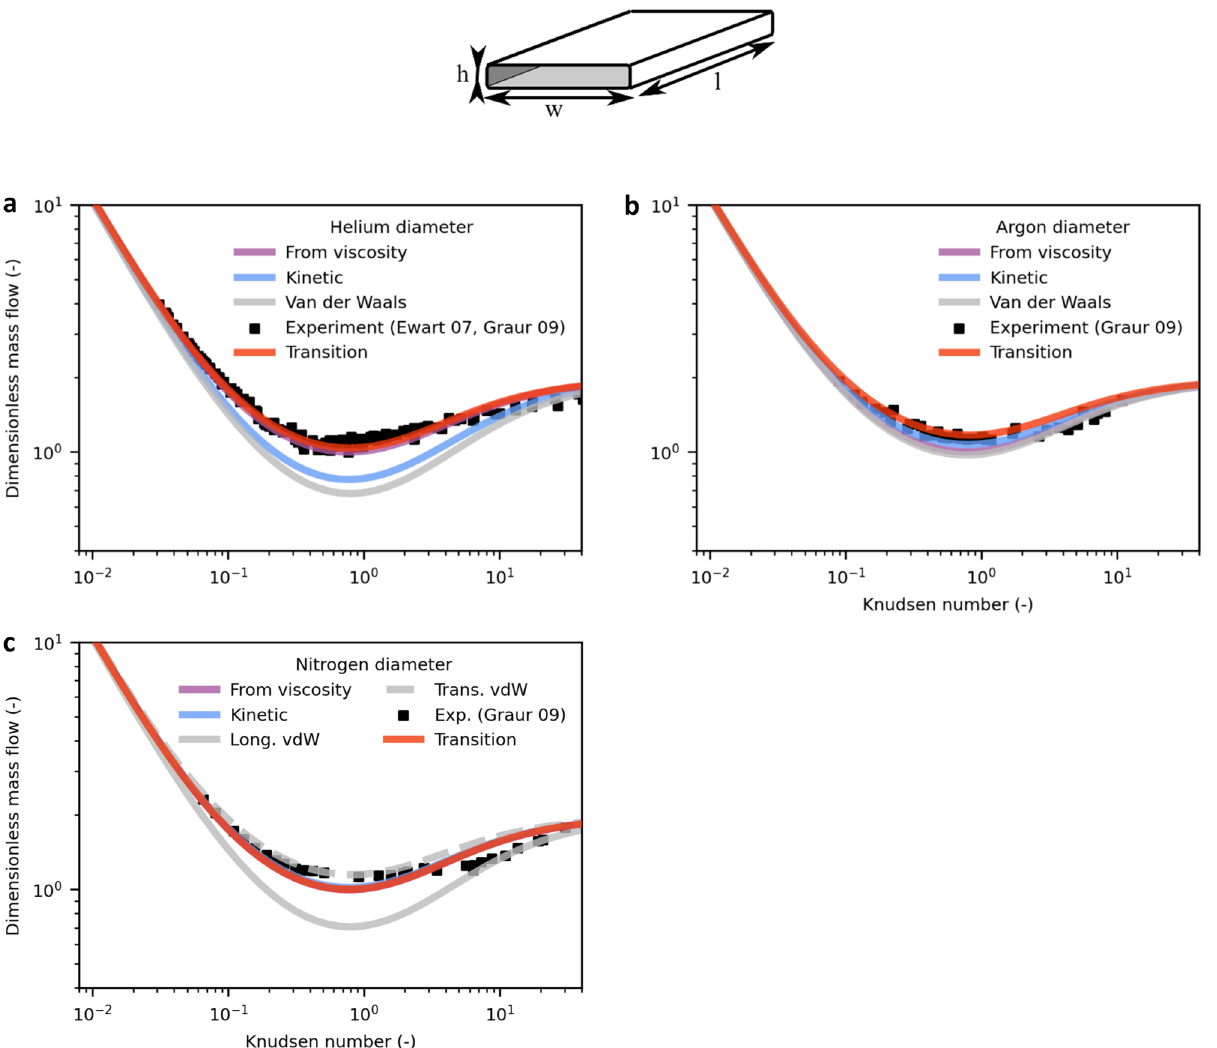
Figure 4. Mass flow in rectangular channels modelled with different molecular diameters compared to experimental data obtained from the literature. Dimensionless mass flow of helium ( a ), argon ( b ) and nitrogen ( c ) predicted by the model. The transition diameters are obtained from data on circular channels. For comparison, the results for different typical literature diameters are shown. For the nonspherical molecule nitrogen, two different van der Waals diameters are given for the transversal and longitudinal orientation,